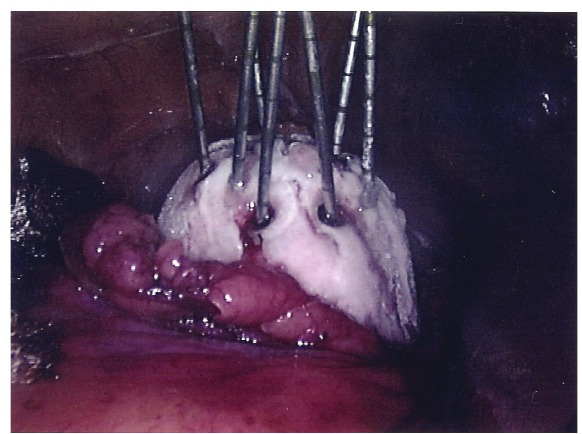
Figure 2: Visualisation of the Ice-ball during thawing, demon- strating arrangement of cryoprobes and temperature monitoring